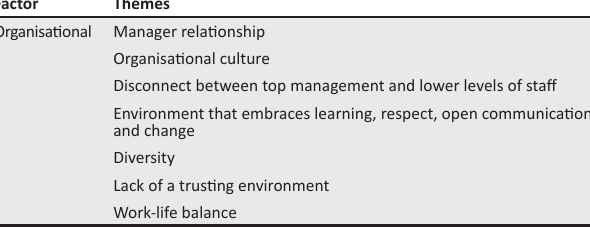
TABLE 4: Themes emerging from organisational factors.